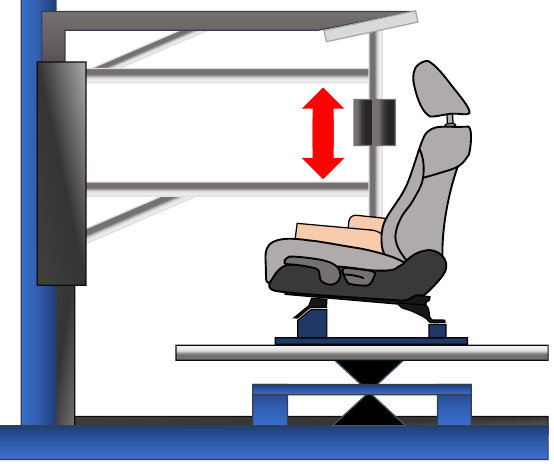
Figure A3. Vibration simulation in automotive